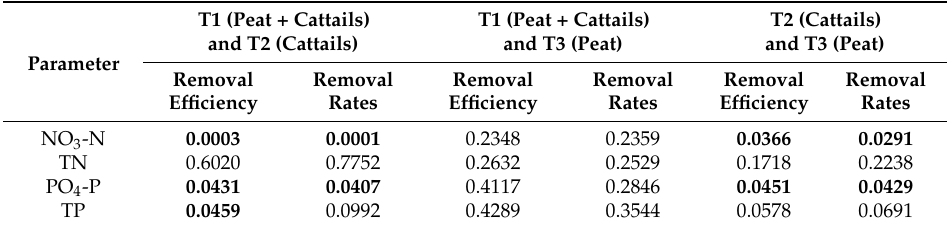
Table 4. Statistical comparison ( p values) between removal efficiencies and removal rates across the treatment wetland reactors 1 .